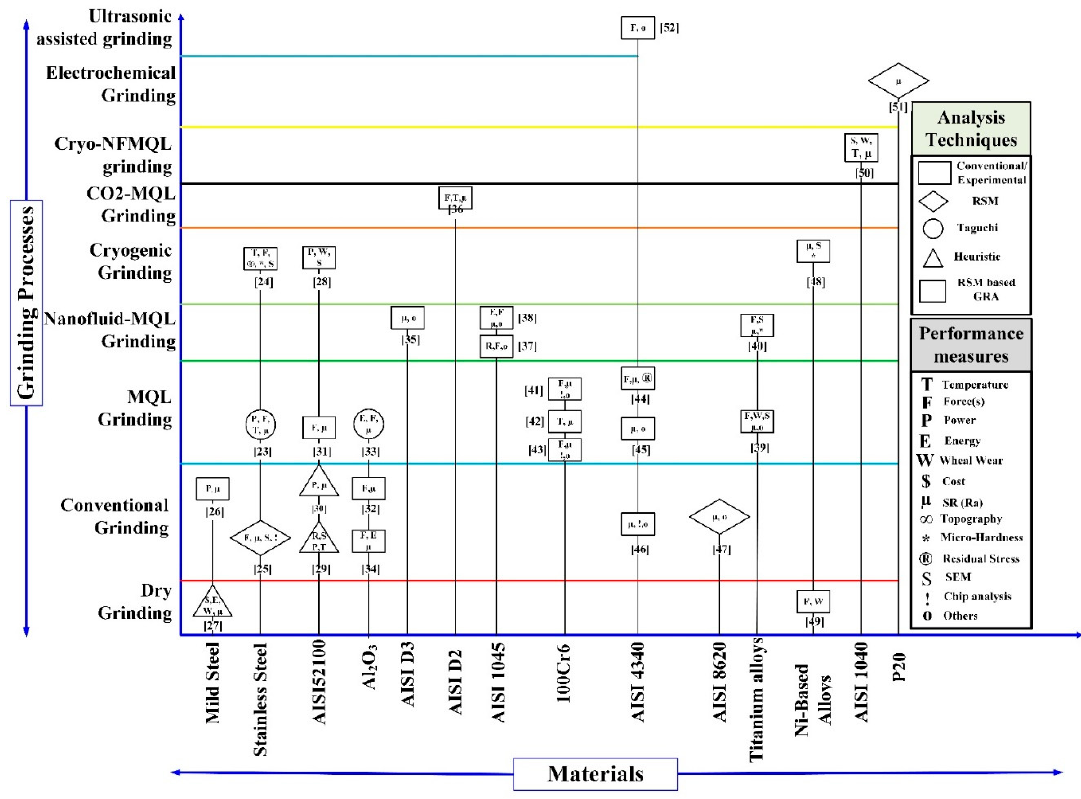
Figure 1. Overview of research on grinding types, the different materials used, and methods used [22–52].